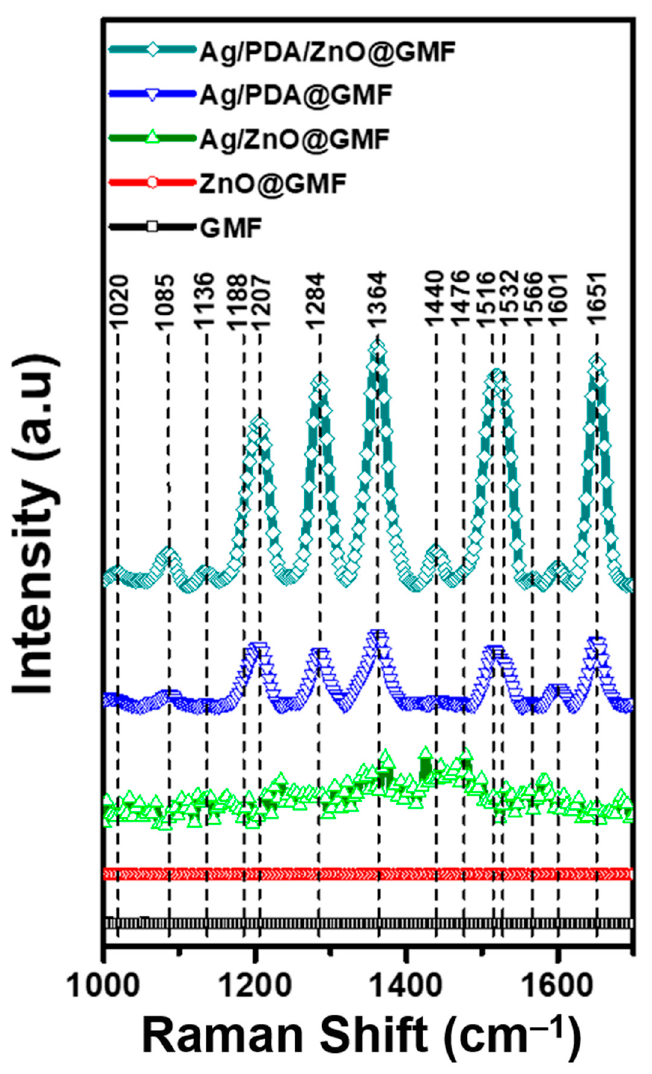
Figure 4. SERS spectra of RhB on GMF, Ag/ZnO@GMF, ZnO@GMF, Ag/PDA@GMF, and Ag/PDA/ZnO@GMF.